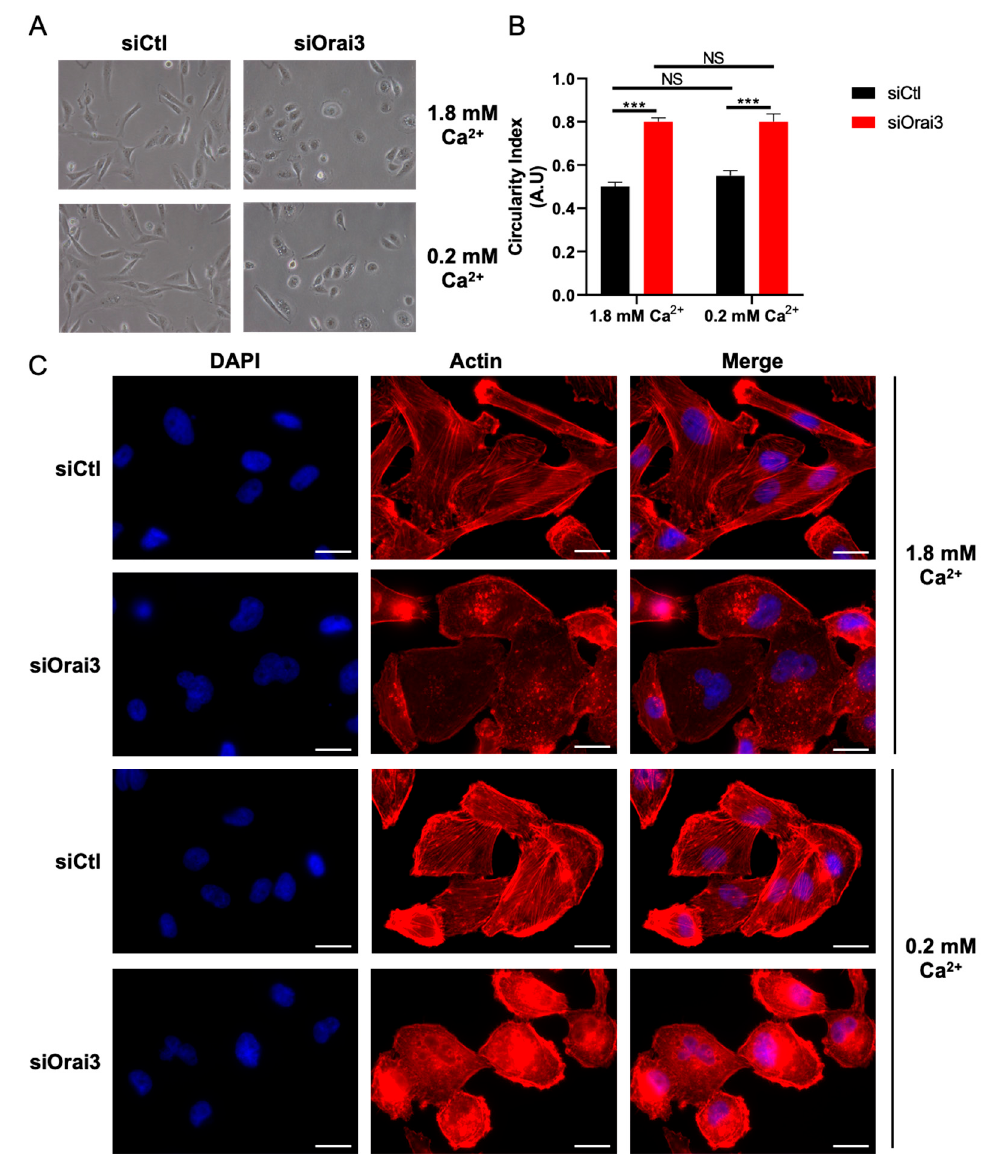
Figure 6. Cell morphology is maintained by the presence of Orai3 and not its activity. ( A , B ). The presence, not the activity of Orai3 regulates cell morphology. Representative images ( A ) and calculation of the circularity index ( B ) of MDA-231 morphology (siCtl 1.8 mM n = 207; siOrai3 1.8 mM n = 211; siCtl 0.2 mM n = 209; siOrai3 0.2 mM n = 198; N = 3; *** p < 0.001; NS Non-Significant). ( C ) Fluorescent rhodamine phalloidin staining showing the actin architecture of siCtl and siOrai3 MDA-231 cells cultivated in 1.8 mM or 0.2 Ca 2+ medium (N = 3). Scale bar: 10 μ m.